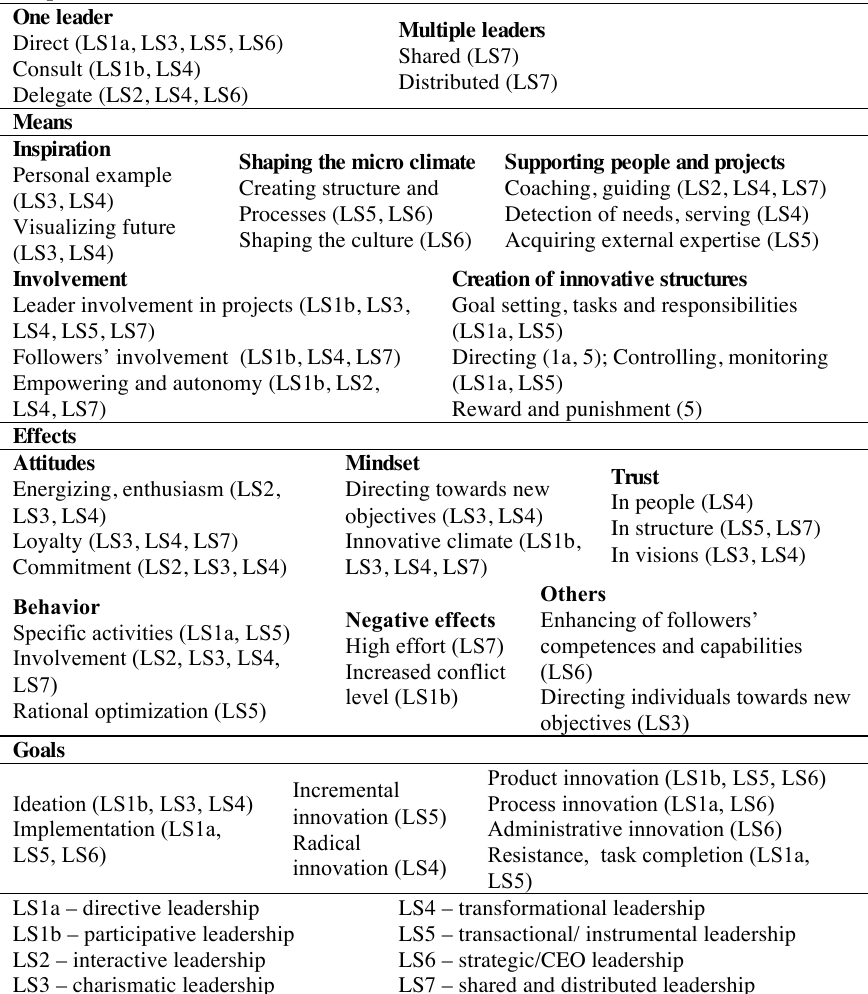
Table 9. Structured integration of insights into the different leadership styles in relation to